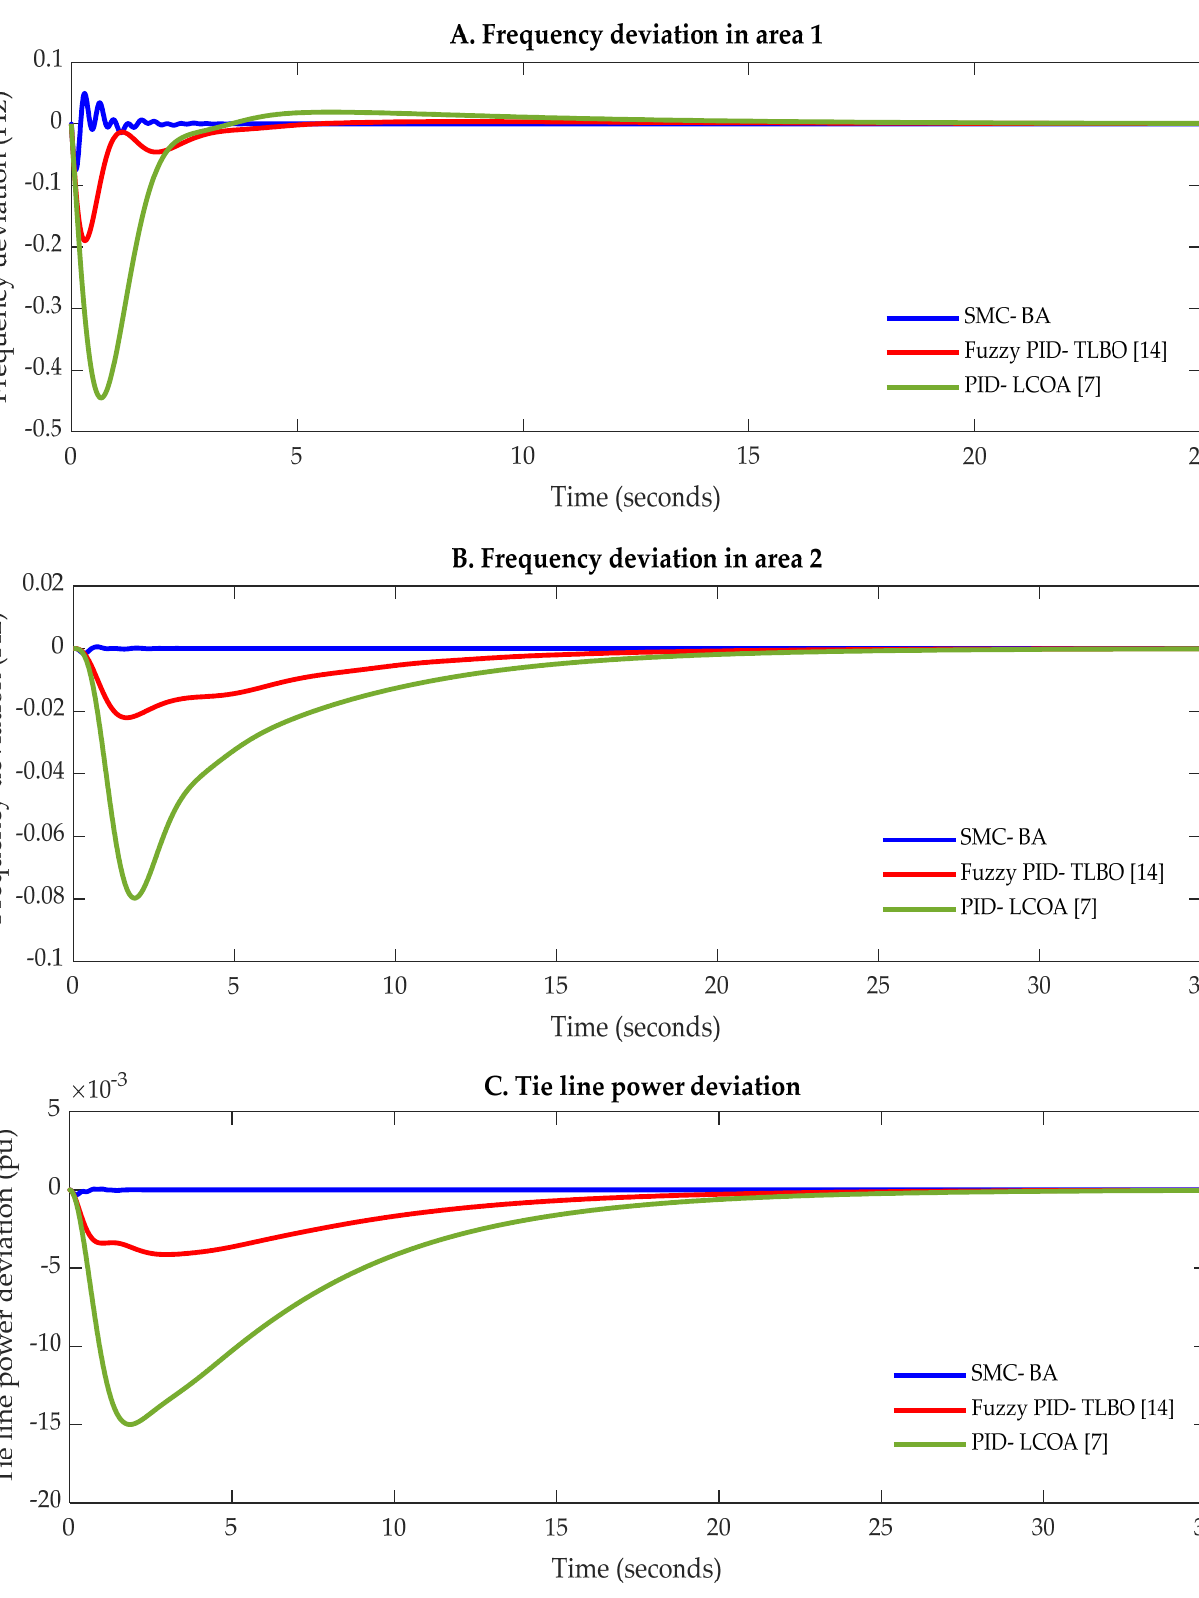
Figure 12. Dynamic response of the system with different controllers under parametric uncertainties, case 6. ( A ) Frequency deviation in area 1; ( B ) Frequency deviation in area 2; ( C ) Tie line power deviation.